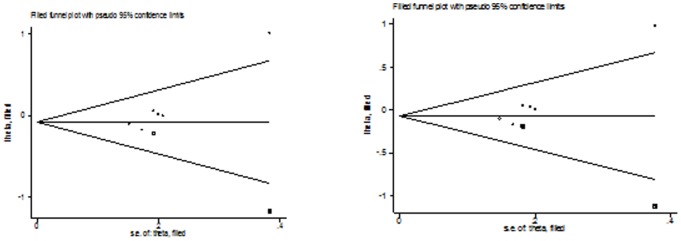
The Duval and Tweedie nonparametric “trim and fill” method's funnel plot funnel plot of the meta-analysis of colorectal cancer risk and CYP1B1 Arg48Gly polymorphism (additive model and dominant model).